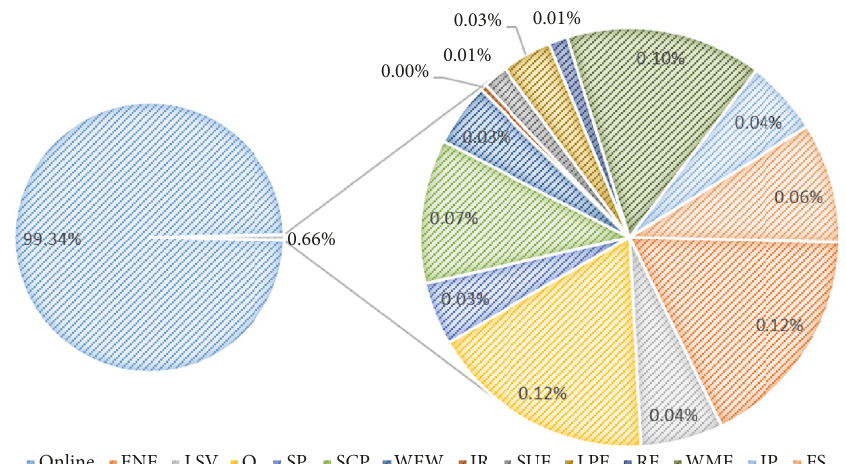
Figure 10: Offline ratio and offline reason